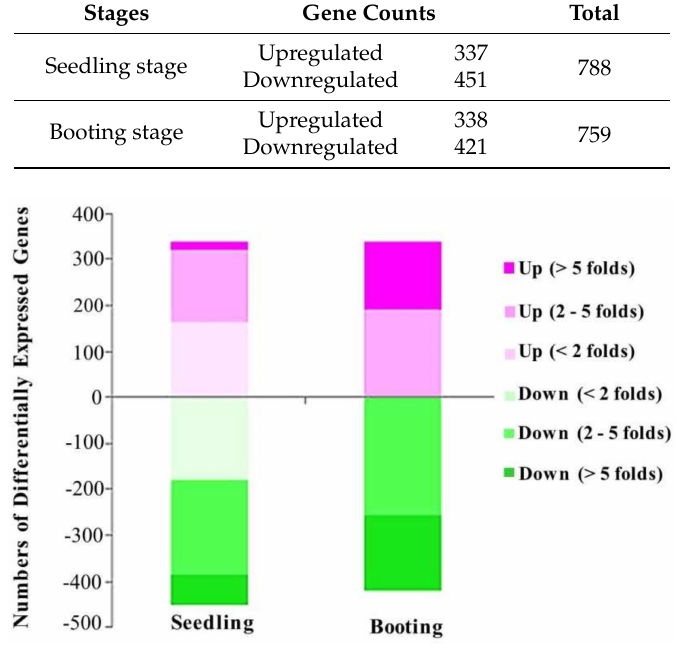
Figure 2. Fold change plot. Number of differentially expressed genes caused by salt stress treatment at the seedling stage and booting